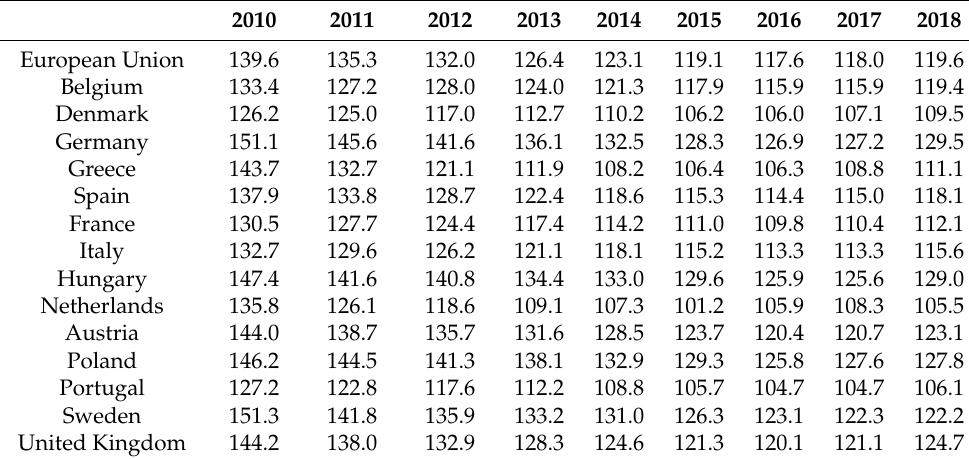
Table 1. Average CO 2 emissions per km (new passenger cars).